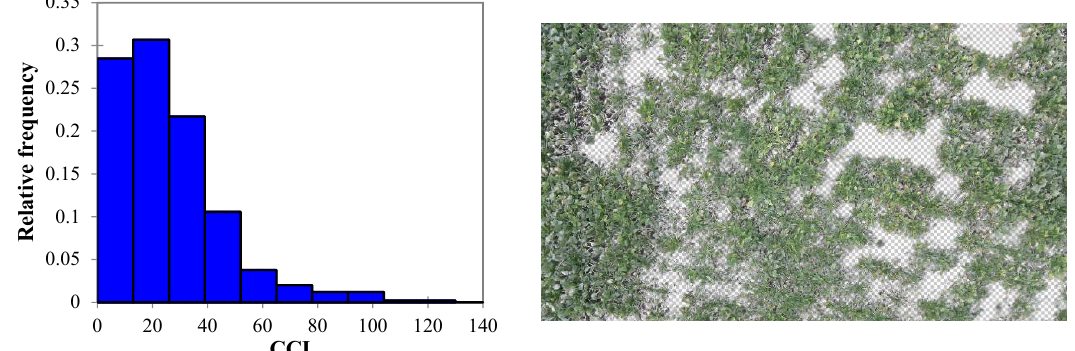
Figure 5. ( Left ) Histogram of CCI values ( n = 500); ( right ) example of UAV-taken photograph after soil background removal.